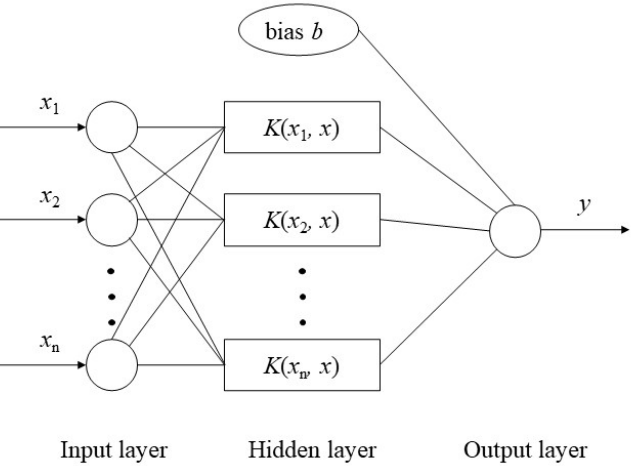
Figure 1. Structure of support vector regression (SVR).